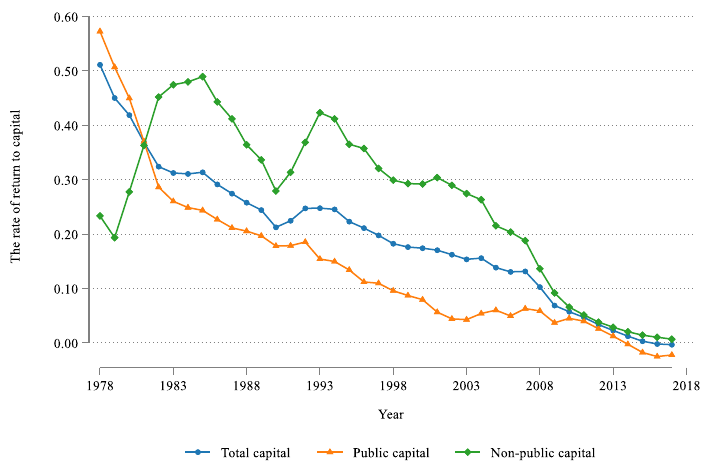
Figure 6. The rate of return to capital. This is the same as the conclusion that [39] found, where the rate of return to capital showed a trend of gradually decreasing or even turning negative. There are two points to make. First, comparing the numerous literature on return to capital studies, the levels and trends of return rates obtained from researches differ significantly, which are explained by the different estimates of the capital stock and the different scopes covered by the studies [40]. The results of [40] show that return to capital presents a very obvious inertial charac- teristic, with a significant decline since 2008. Reference [41] focused on the study of the re- turn to capital of industrial enterprises, and believed that the return to capital continued to rise. According to [42], although the rate of return to industrial capital in China is very high, the overall rate of return to capital has a downward trend, which is consistent with the trend